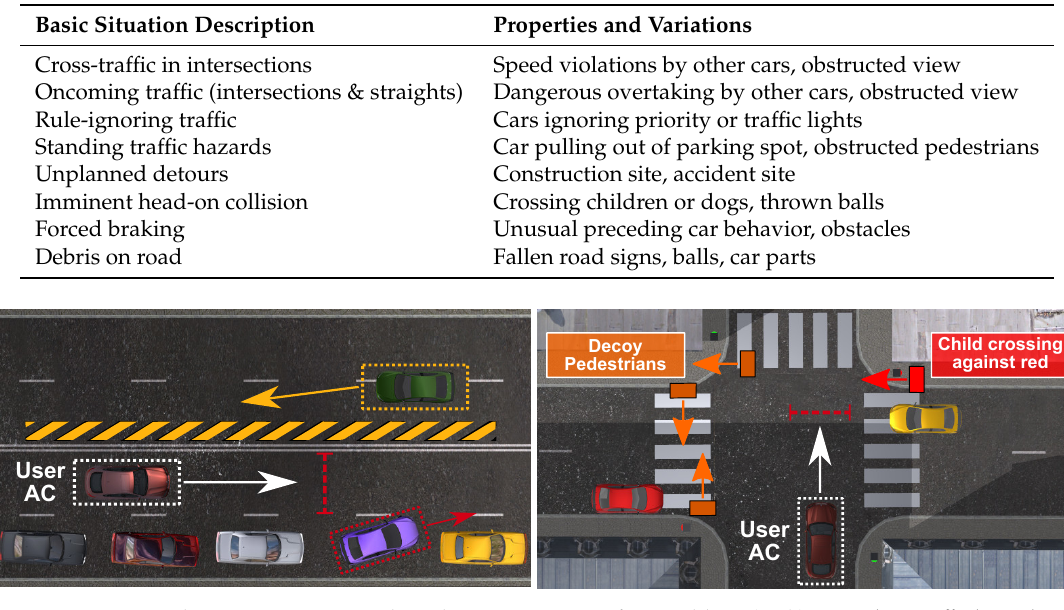
Figure 3. Top-down view on exemplary driving situations from Table 2. ( Left ) a standing traffic hazard with one car pulling out late from a parking spot in front of the approaching AC, forcing it into full braking; ( Right ) an imminent head-on collision case with a child emerging from cover to cross the road. Decoys provide additional stimuli for a more realistic scene, best viewed in